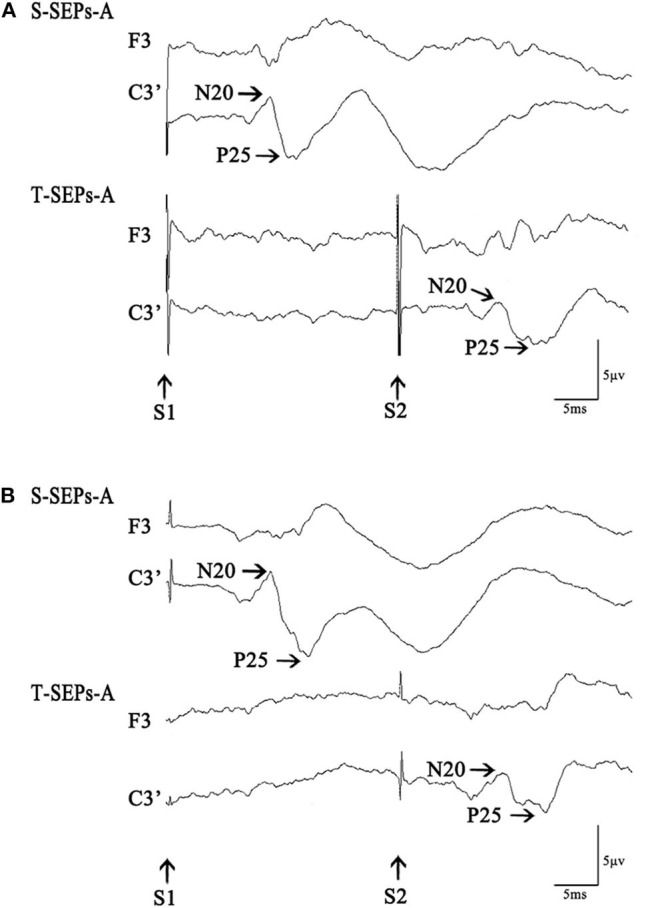
S-SEPs-A and T-SEPs-A in a control subject (A) and a Tourette syndrome (TS) patient (B). S-SEPs-A are somatosensory evoked potentials by a single-pulse stimulus. T-SEPs-A are obtained by subtracting S-SEPs-A from somatosensory evoked potentials elicited by paired stimuli (P-SEPs-A) at an interstimulus interval (ISI) of 40 ms.